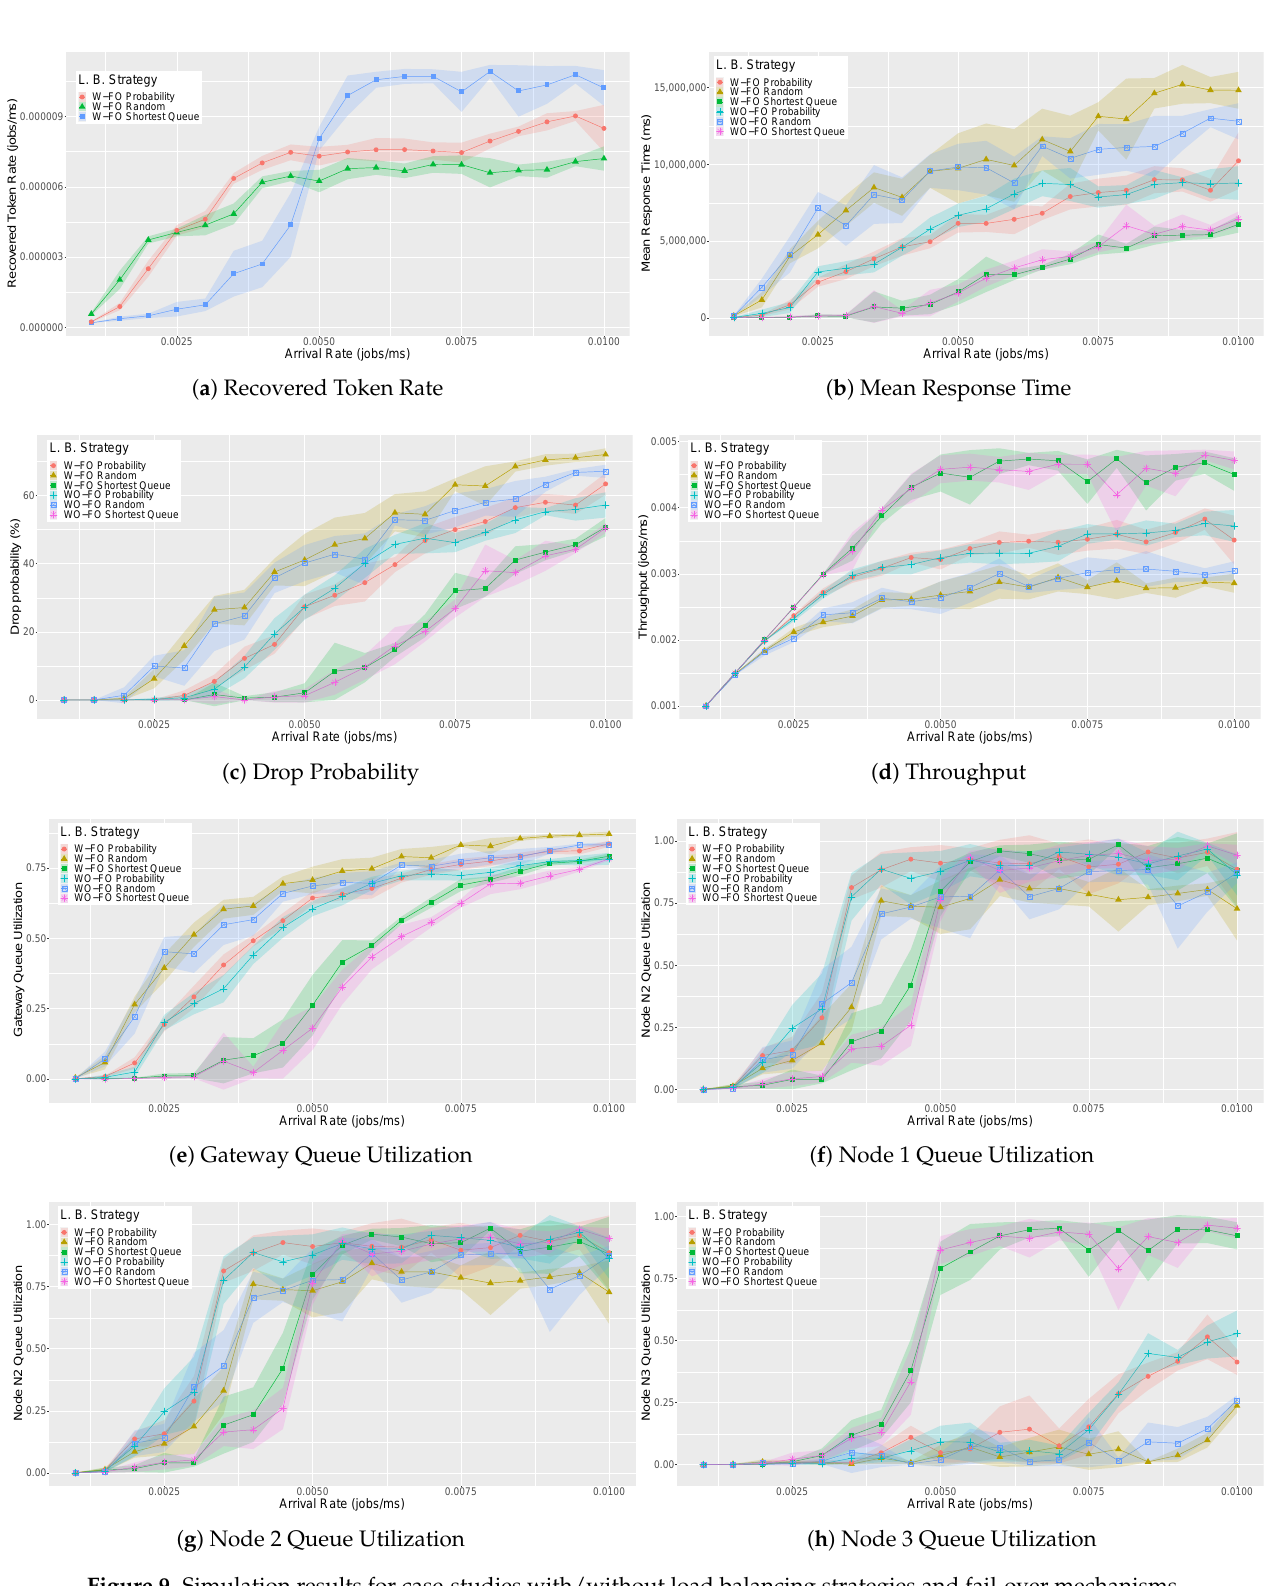
Figure 9. Simulation results for case-studies with/without load balancing strategies and fail-over